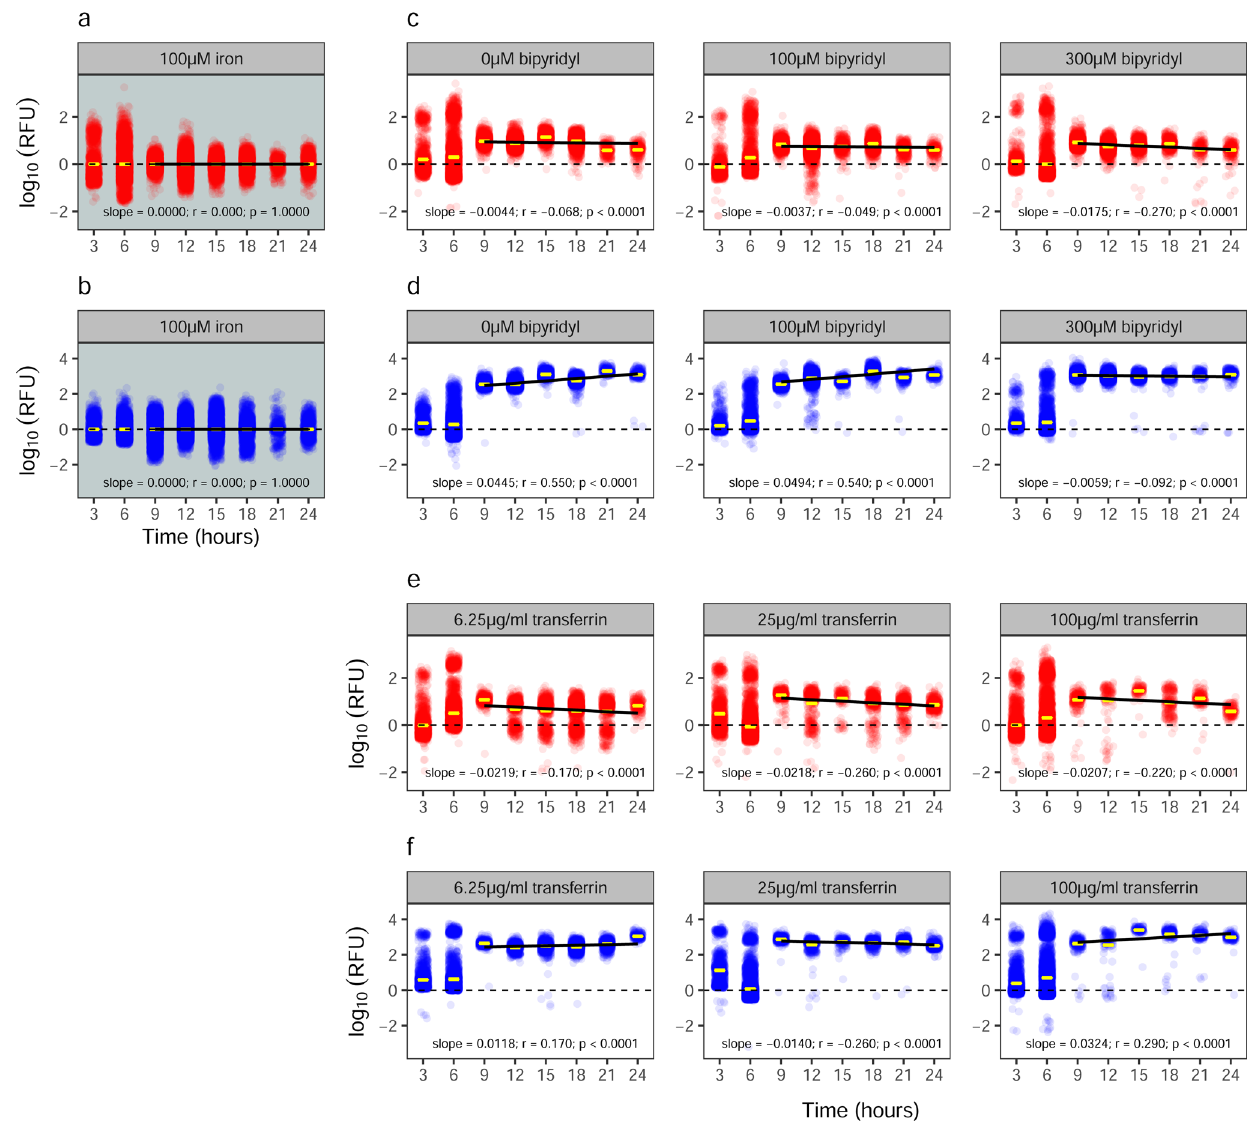
Fig. 3 Single-cell siderophore gene expression patterns across time and media. The expression of pyochelin (red: pchEF ) and pyoverdine (blue: pvdA ) synthesis genes measured with the double reporter PAO1 pvdA :: mcherry – pchEF :: egfp across a range of CAA media differing in their levels of iron limitations. Each dot represents an individual cell with gene expression shown as relative fl uorescent unit (RFU), representing the blank-corrected log-transformed integrated fl uorescence density, log(IntDen). Values > 0 represent cells with gene expression above background level. a , b Iron-replete CAA medium (100 µ M FeCl 3 ); c , d CAA media with increasing concentration of the iron chelator bipyridyl; e , f CAA media with increasing concentration of the iron chelator apo-transferrin. Yellow bars represent the mean gene expression of all cells at a speci fi c timepoint. Black solid lines indicate correlation trend lines of gene expression from the 9th hour onwards. The Pearson correlation coef fi cient r and the p -value are p rovided in each panel together with the slope of the